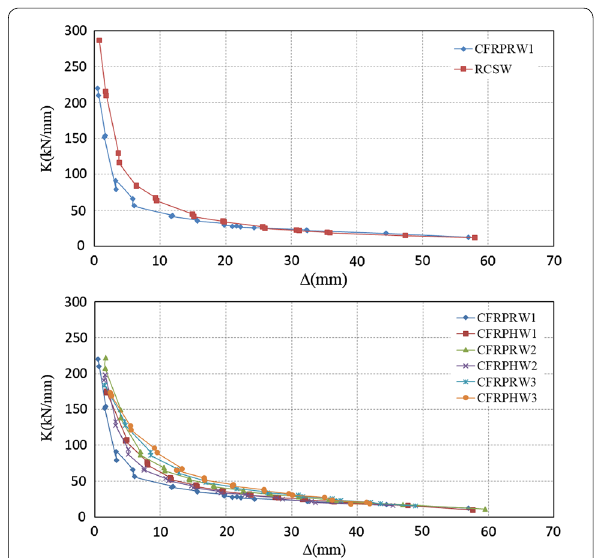
Fig. 15 Stiffness degradation